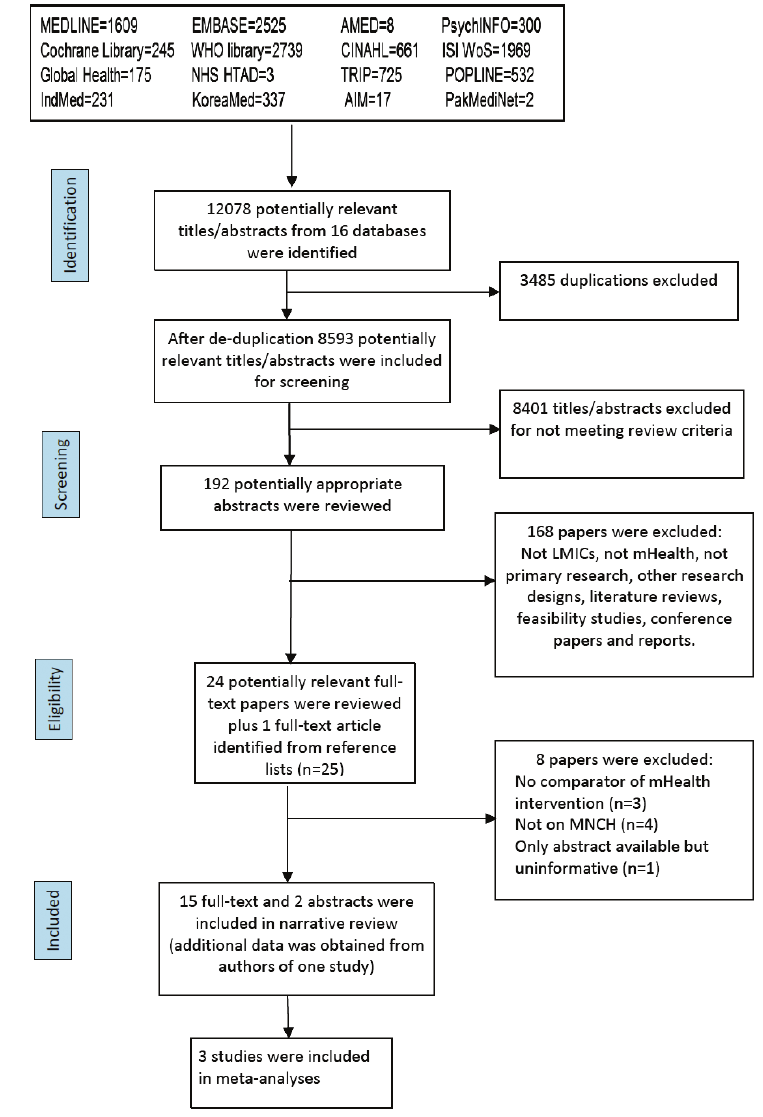
Figure 1. PRISMA flow diagram for database search of studies on mHealth interventions for maternal, newborn and child health in low– and middle–in- come countries,